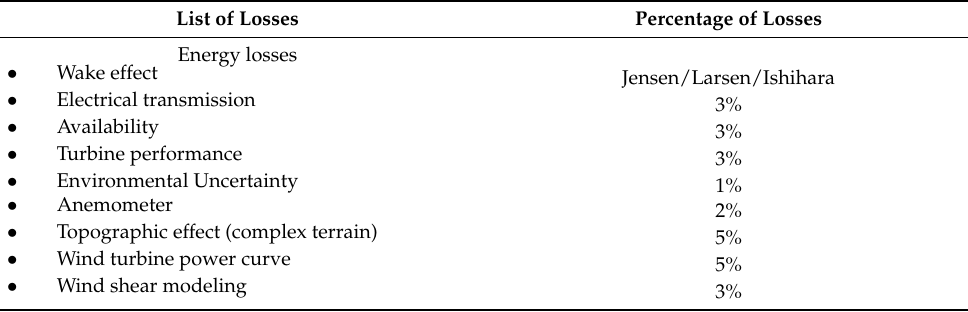
Table 3. Energy losses and uncertainties to estimate the net annual energy